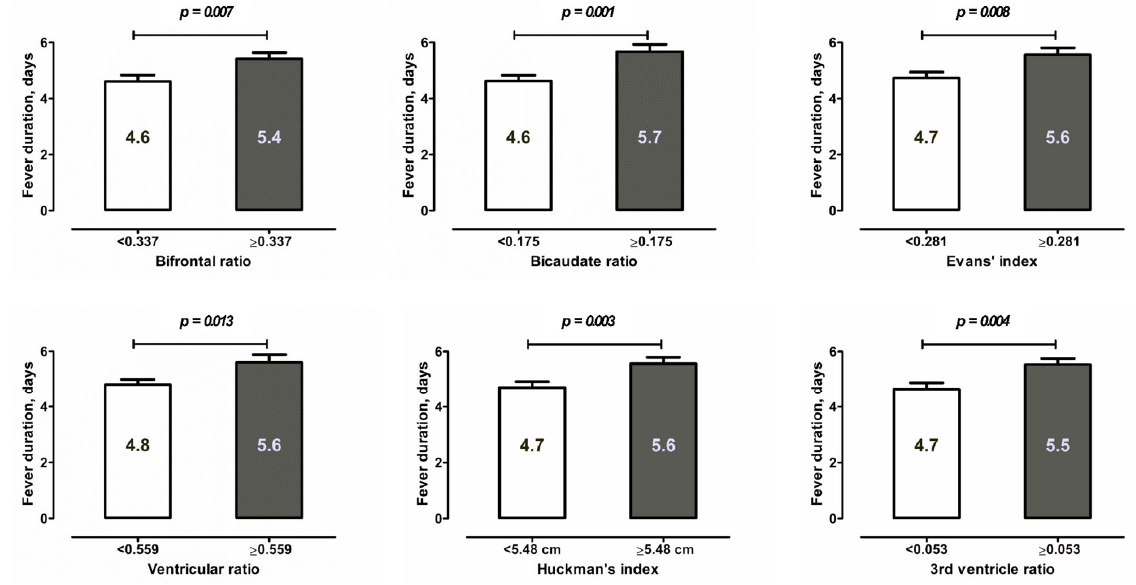
Figure 4. Mean duration of fever after SAH (in days) in different subgroups depending on the values of the ventricular indices. Larger ventricles are significantly and independently associated with a longer duration of fever.